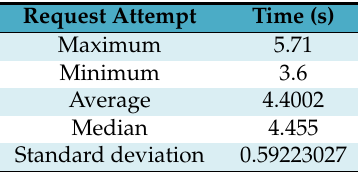
Table 7. Most prominent figures obtained from periodic data subscription measures.